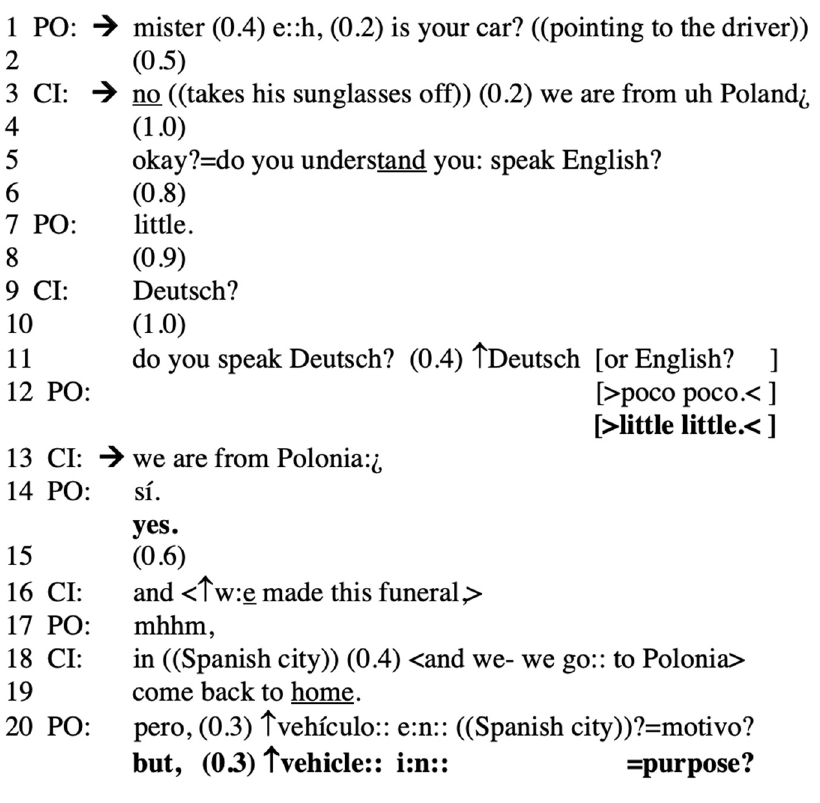
Figure 6. Extract